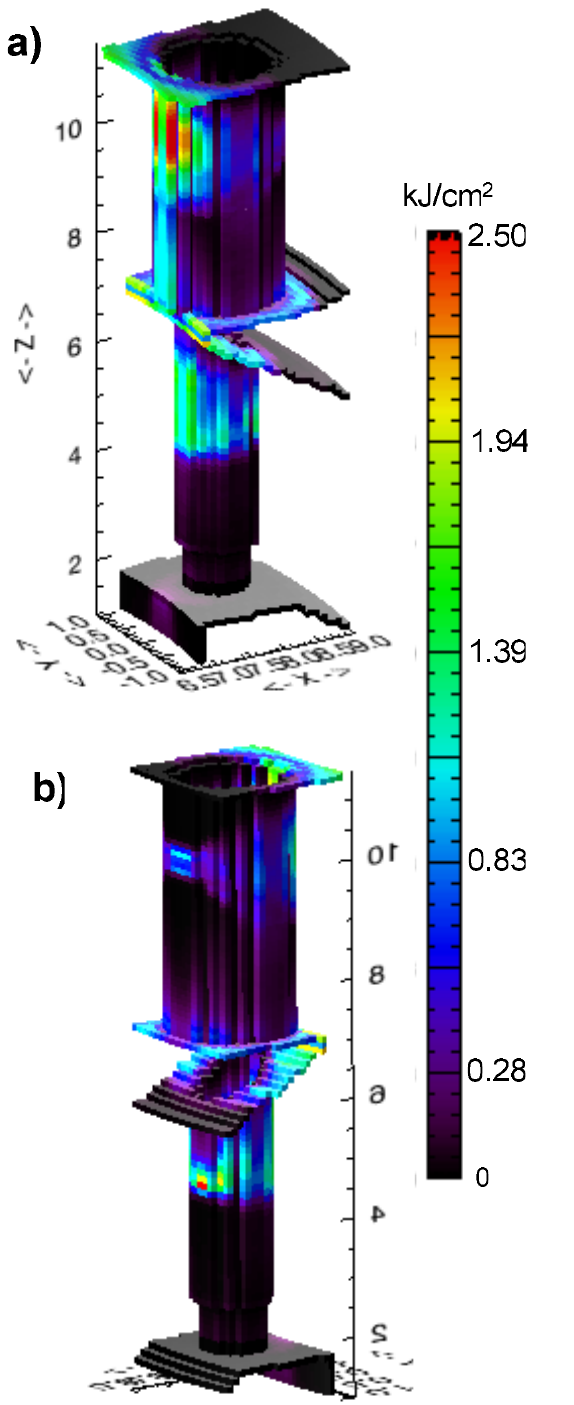
FIG. 7. (Color) Electron energy surface deposition on the anode posts after 120 ns for the plasma injection simulation ( D (cid:4) 0 : 0075 ml = ns , case 4F) with views highlighting (a) the down- stream side of the posts and (b) the upstream